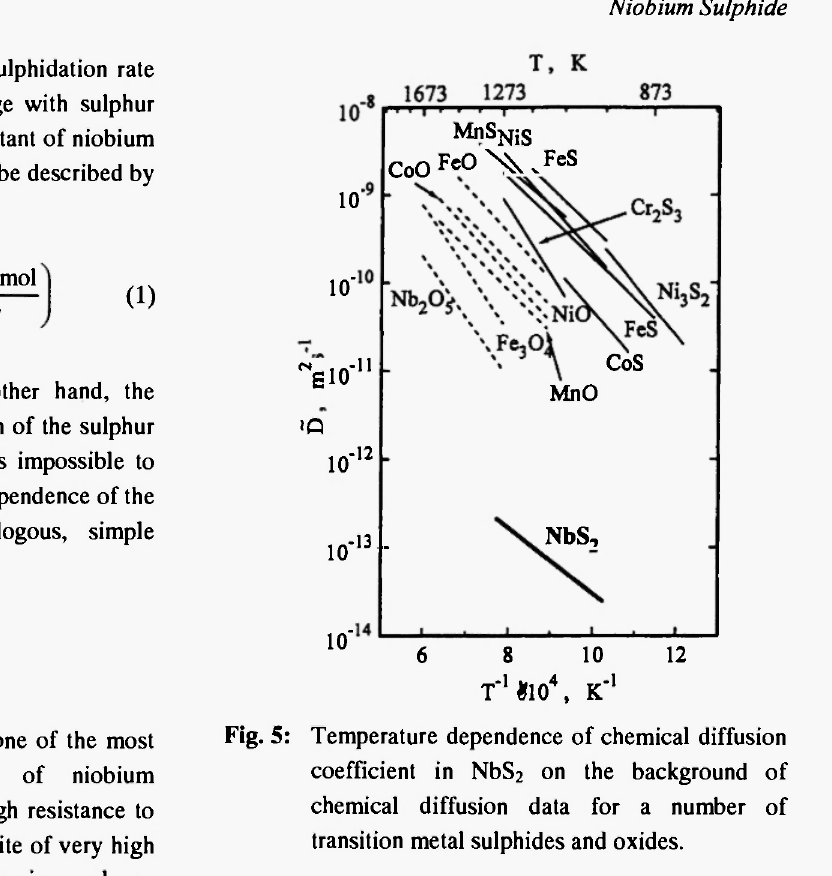
Fig. 5: Temperature dependence of chemical diffusion coefficient in NbS 2 on the background of chemical diffusion data for a number of transition metal sulphides and